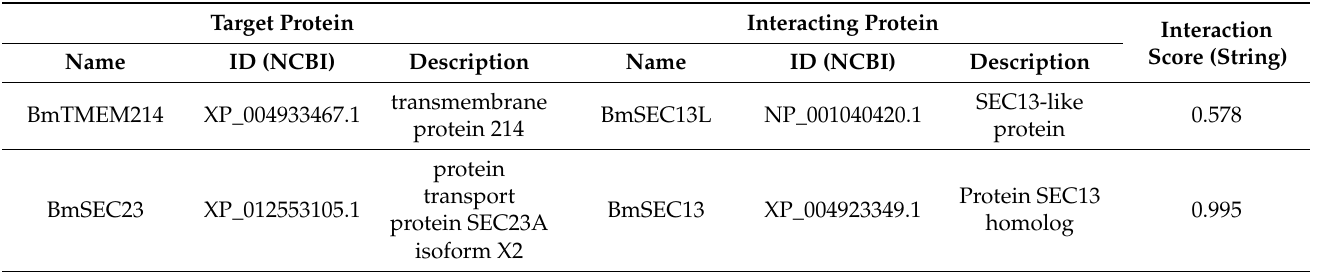
Table 1. Information of proteins used in I2H tests.